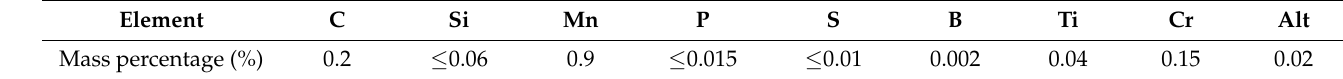
Table 1. 10B21 target composition requirements